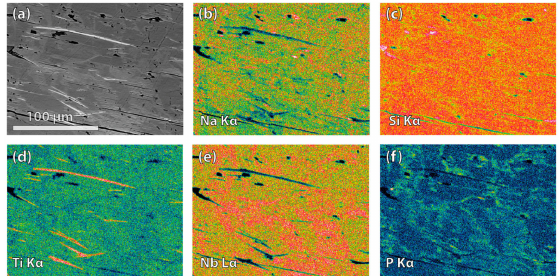
Figure 1. Backscattered electron image of shkatulkalite crystal ( a ) and X-ray distribution maps for Na K α ( b ); SiK α ( c ); TiK α ( d ); NbL α ( e ); PK α ( f )